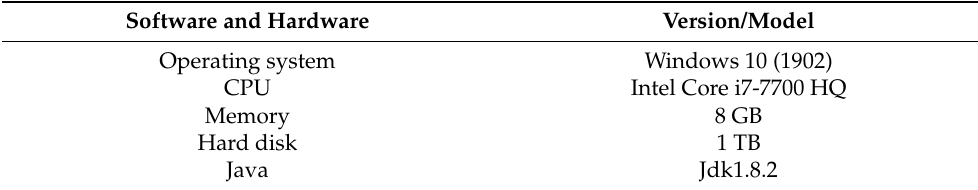
Table 1. The computer software/hardware configuration.